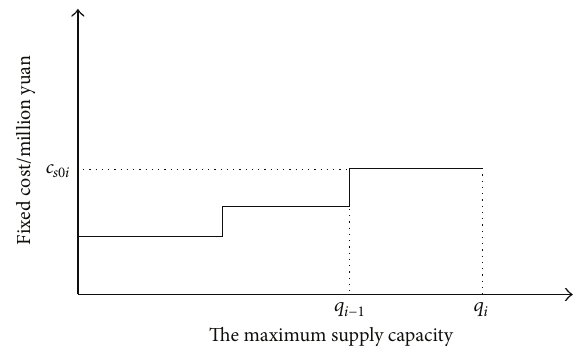
Figure 2: The relationship between fixed cost and the maximum supply